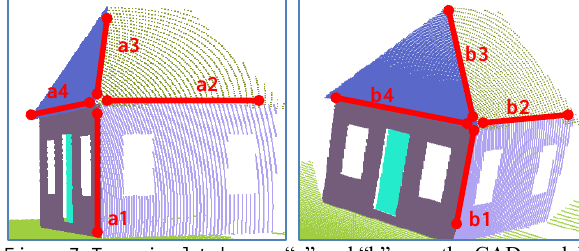
Figure 7. Two simulated scans “a” and “b” over the CAD model after the segmentation and extraction of linear features